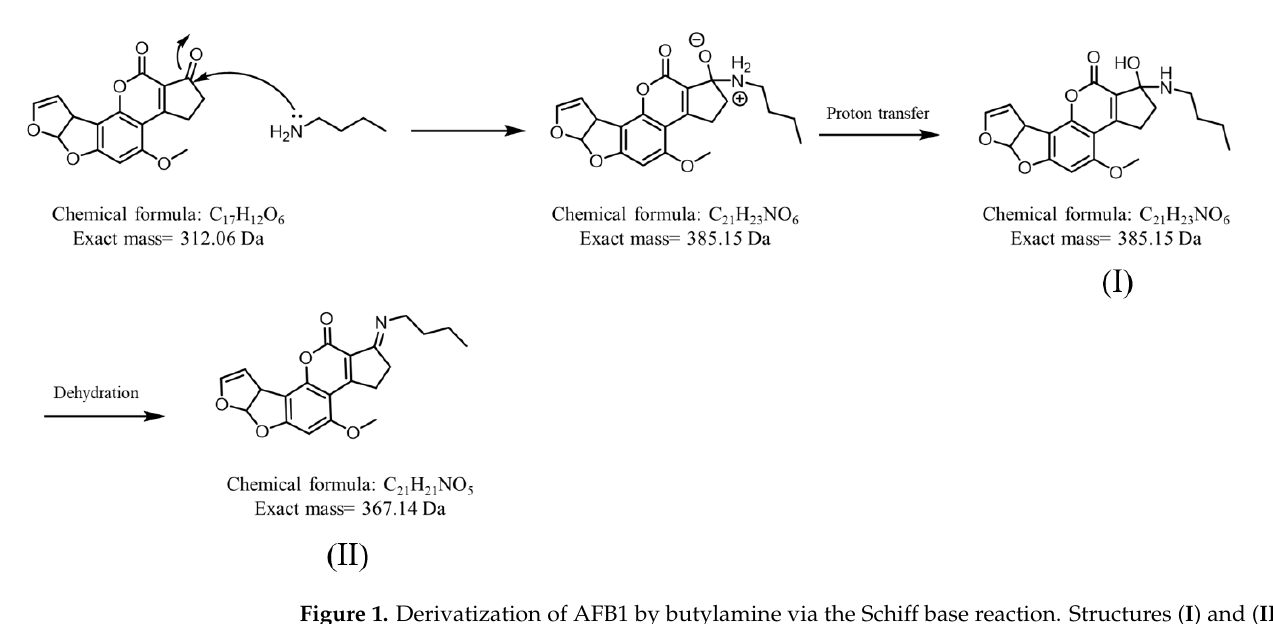
Figure 1. Derivatization of AFB1 by butylamine via the Schiff base reaction. Structures ( I ) and ( II ) show the reaction intermediate and product, respectively.